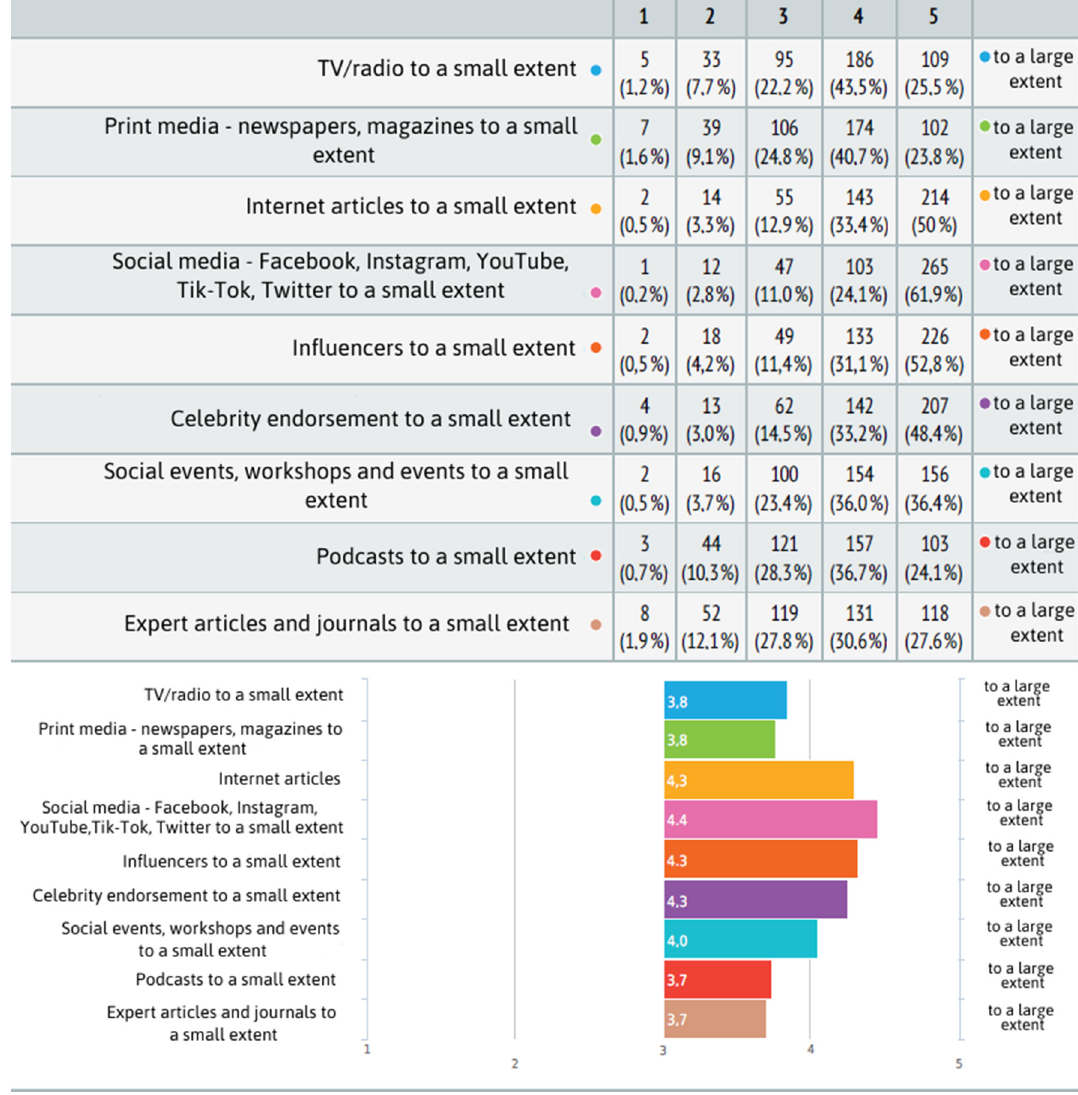
Figure 2. Recommended use of communication tools/media by the respondents in the communication of sustainable fashion.